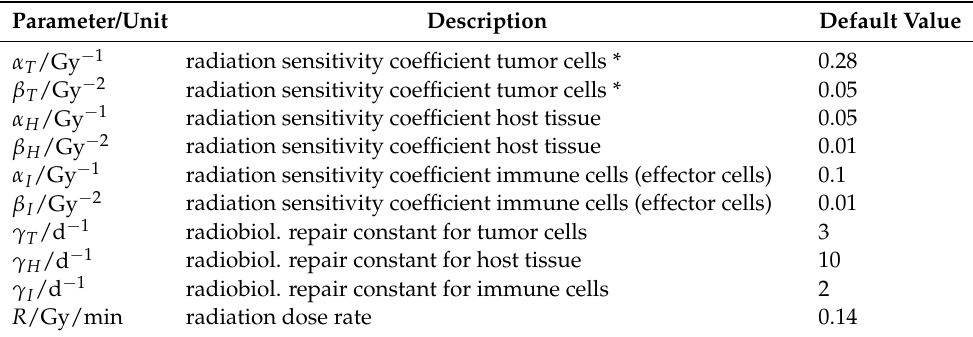
Table 3. Model parameters for radiobiological model: parameters used for the investigated scenario; parameters considered as susceptible for hyperthermia are indicated by an